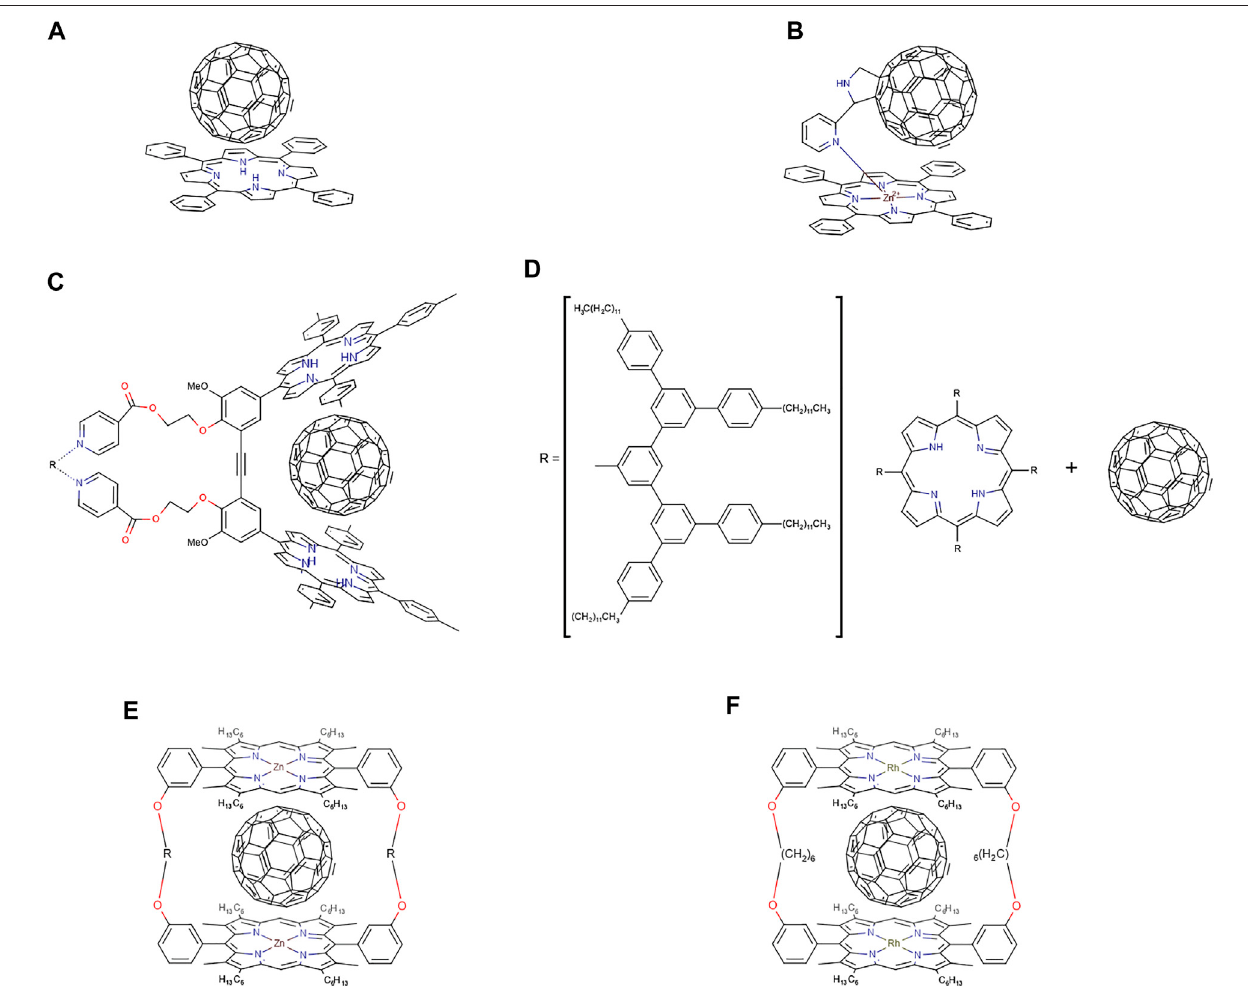
FIGURE 10 | Representation of (A) cocrystallite-denoted H 2 TPP · C 60 (Boyd et al., 1999), (B) zinc tetraphenylporphyrin C 60 conjugate system (K a (cid:2) 7.3 × 10 3 M − 1 ) (Solladié et al., 2003), (C) supramolecular oligophenylenevinylene-C 60 conjugate (K a (cid:2) 5.1 × 10 3 M − 1 ) (Gutiérrez-Nava et al., 2003), (D) components of a self-organised supramolecularcomplexcomposed ofrigiddendriticporphyrin and C 60 (K a (cid:2) 2.57 × 10 4 M − 1 ) (Kimura etal., 2002), (E) cyclicdimer ofmetalloporphyrininahighly stable inclusion complex with C 60 (K a (cid:2) 6.7 × 10 5 M − 1 ) R (cid:2) (CH 2 ) 6 (Tashiro et al., 1999), and (F) cyclic rhodium (III) metalloporphyrin structure acting as host for fullerene molecules (K a , C 60 (cid:2) 2.4 × 10 7 M − 1 ; K a , C 70 (cid:2) 1.0 × 10 8 M − 1 ) (Zheng et al.,